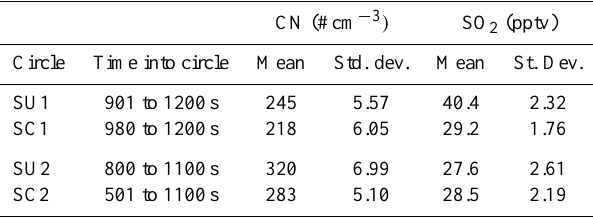
Table 2. NCAR CN number concentrations and SO 2 concentrations for the CBL circles of RICO RF14 without direct effects of ship plumes and precipitation. Measurements of CN and SO 2 sampled at 25s − 1 were integrated to 1s.